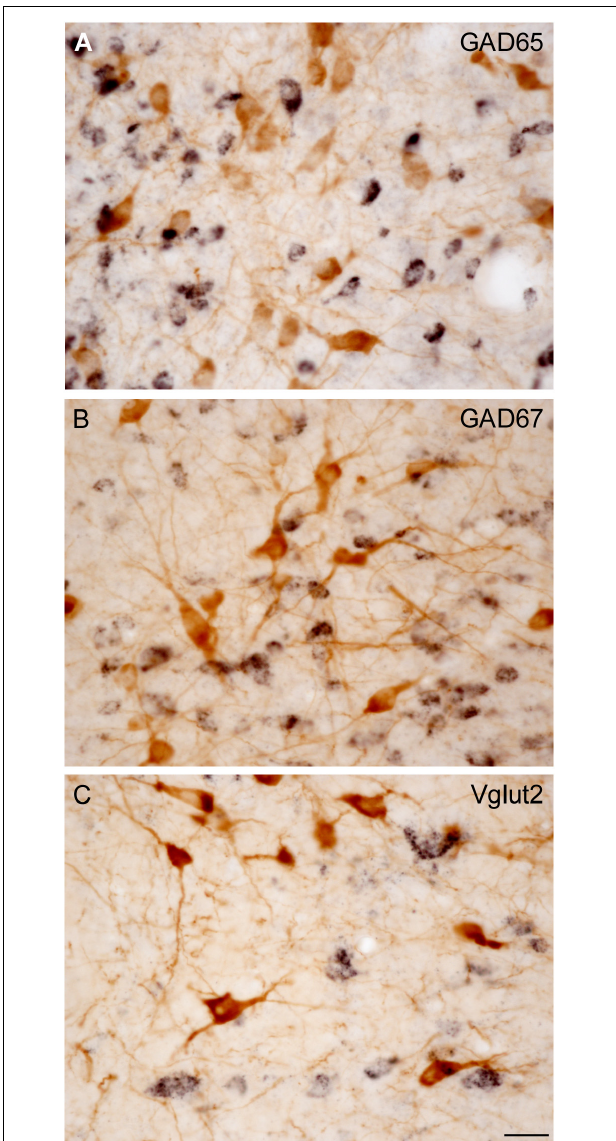
FIGURE 3 | Direct visualization of ChAT-immunoreactive cells and GAD65-, GAD67-, or Vglut2-positive cells in the PPN and LDT. (A–C) Microphotographs show examples of dually labeled sections used for quantification. This protocol allowed to directly and distinctly visualize both ChAT-immunoreactive neurons ( A–C , brown cells) and biotin-labeled GAD65- (A) , GAD67- (B) , or Vglut2-positive neurons (C) displaying a black granular labeling. Scale bar: 20 µ m.